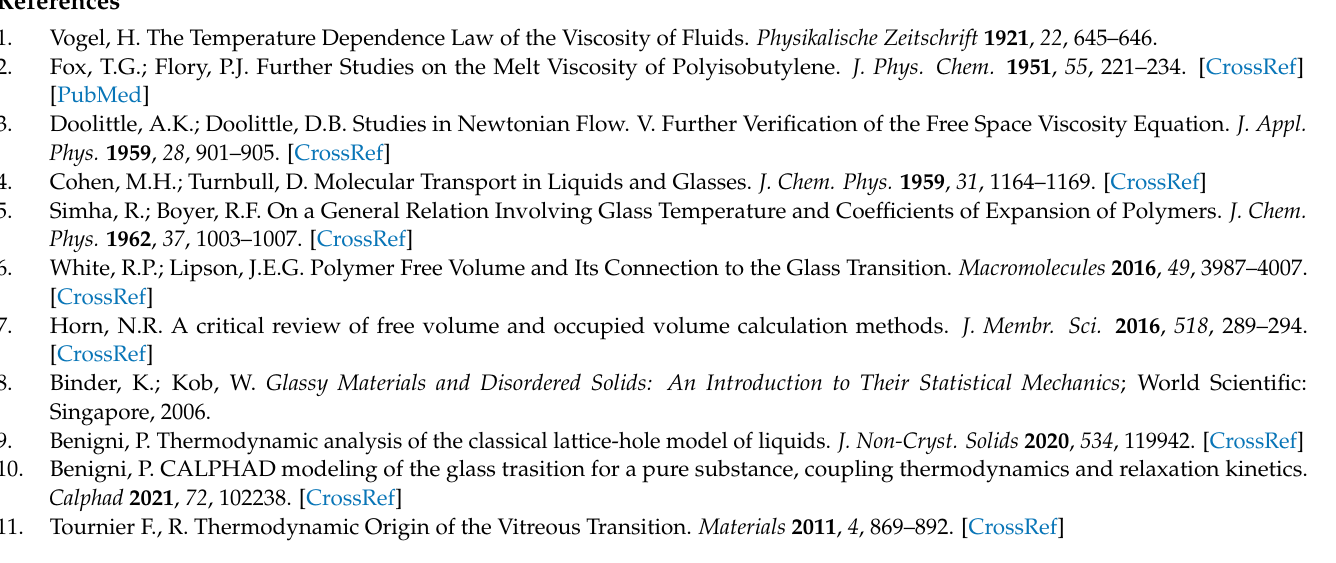
temperature dependence unoccupied volumes with different probe sizes; Figure S5: Snapshots of another way to color the fast monomers in CRRs; Figure S6: Monomer number distribution in “static cage” around all monomers and fast 10% ones at different